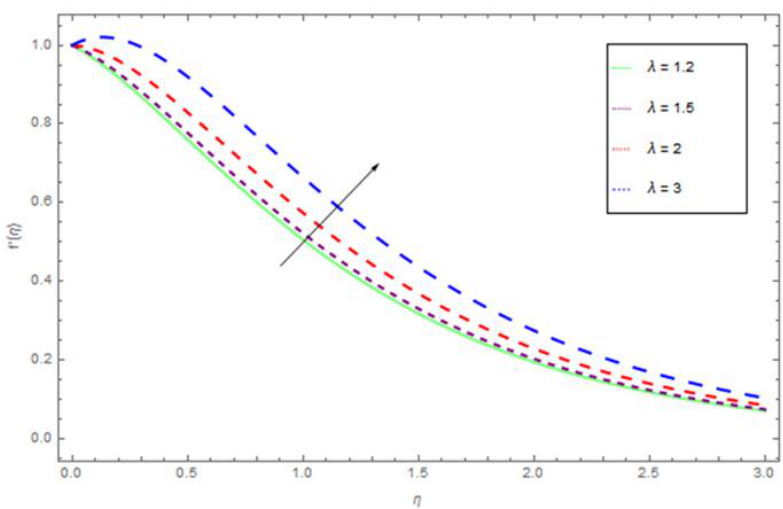
Figure 5. The e ff ect of γ on f (cid:48) ( η ) when M = 0.6, k 1 = 0.5, λ = 0.3, γ = 0.4. Figure 5. The effect of  on .